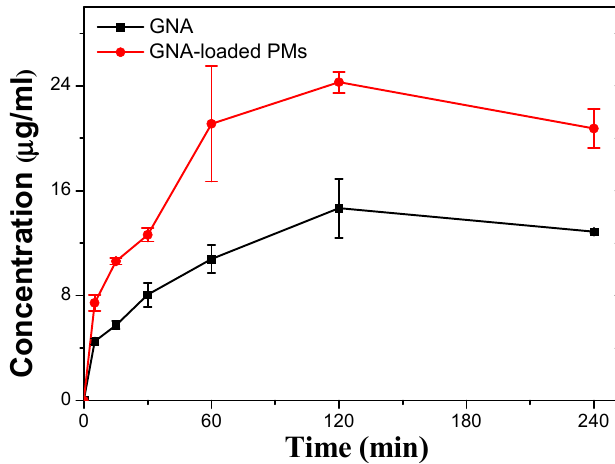
Figure 7. Effect of time on the cellular uptake of GNA in Hep G2 cells. Hep G2 cells were incubated with GNA and GNA-loaded PMs (10 µ g of GNA) for 5, 15, 30, 45, 60, 120, and 240 min, respectively. Intracellular GNA was assayed by HPLC (Mean ± S.D., n = 3).